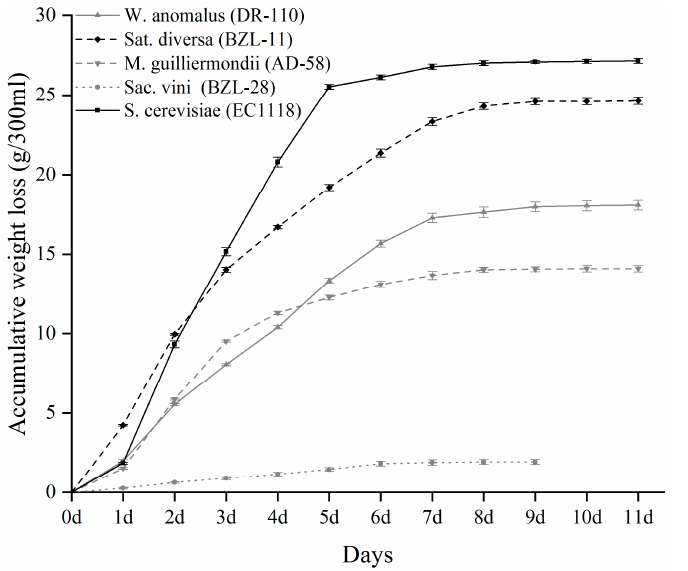
Figure 1. Fermentation kinetics of four indigenous non- Saccharomyces yeast isolates and EC1118 in SGJ.